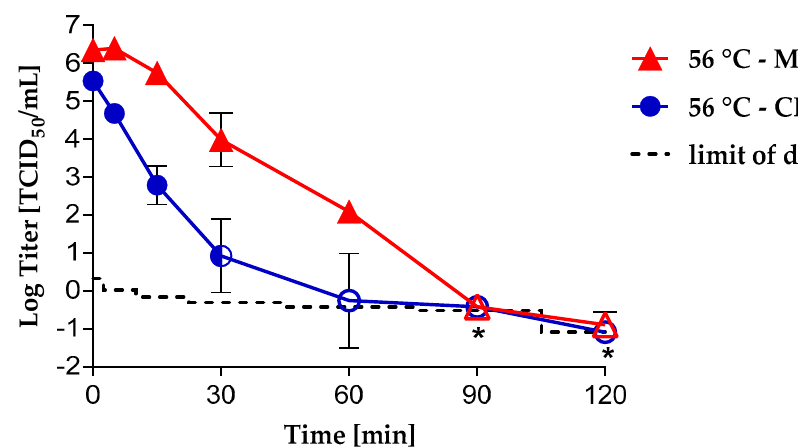
Figure 1. Heat inactivation kinetics of CHIKV and MAYV by heat treatment of cell culture medium. Heat-treated samples (mean values from triplicate runs) are indicated by circular (CHIKV) or triangular (MAYV) symbols. Error bars represent the standard deviation. *CHIKV data from one experiment; closed symbols = infectivity was detected; open symbols = no residual infectivity was detected; half-open symbol = in 2/3 experiments, residual infectivity was detected; the limit of detection depends on the sample volume tested.